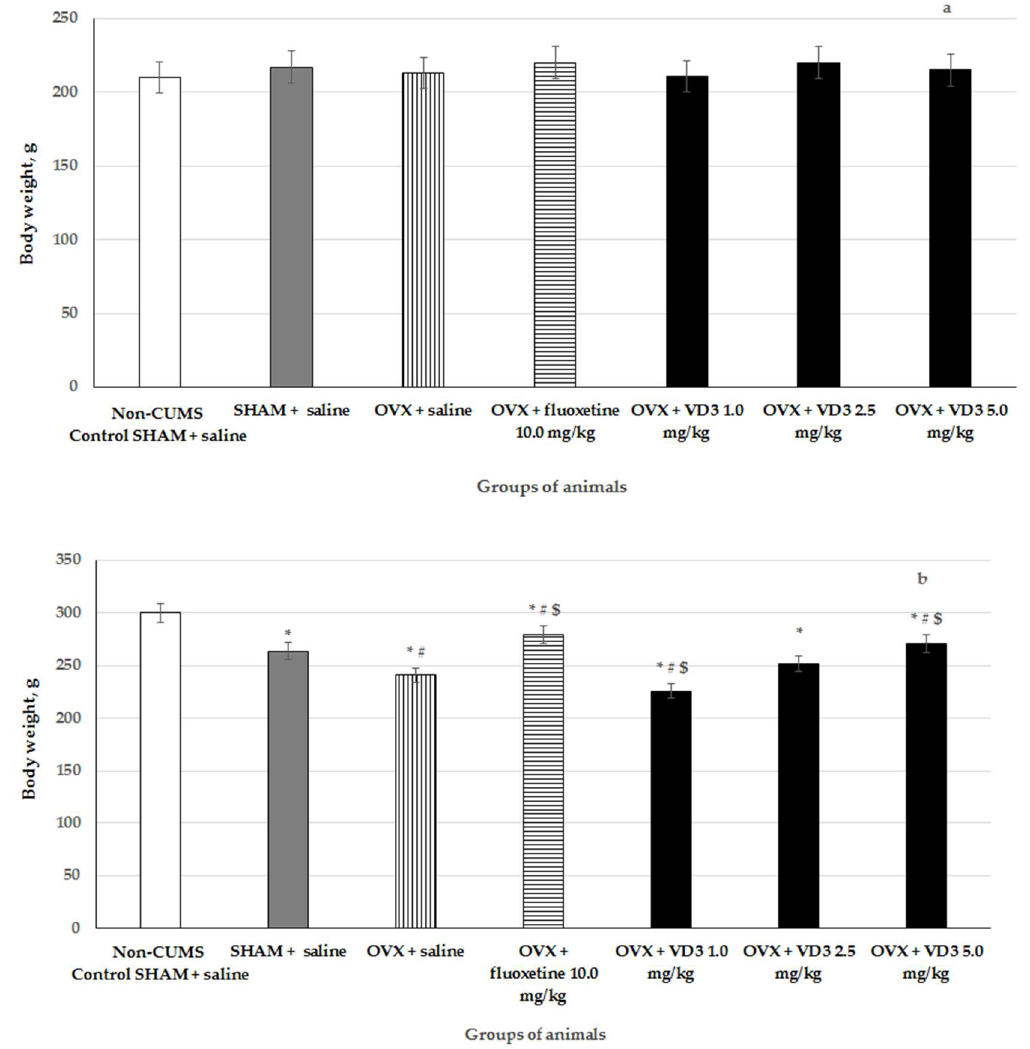
Figure 2. Effects of VD 3 administered in various doses on the bodyweight of long-term OVX rats subjected to CUMS on day 0 ( a) the beginning of stress protocol) and on day 28, ( b) the end of stress protocol). *— p < 0.05 versus the non-CUMS SHAM group (control group) treated with saline, #— p < 0.05 versus the SHAM group with CUMS treated with saline, $— p < 0.05 versus the long-term OVX group with CUMS treated with saline. The data are presented as the mean ± SD; n = 7 in each group.